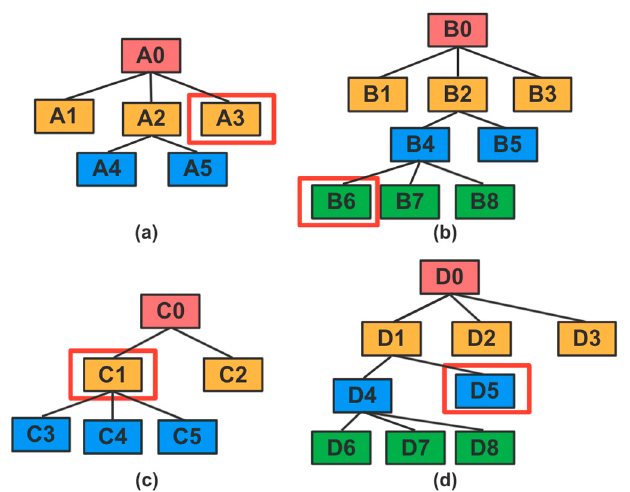
Figure 5. Hierarchical tree structure for attributes A, B, C and D. ( a ) three-layer tree structure of attribute A; ( b ) four-layer tree structure of attribute B; ( c ) three-layer tree structure of attribute C; ( d ) four-layer tree structure of attribute D.